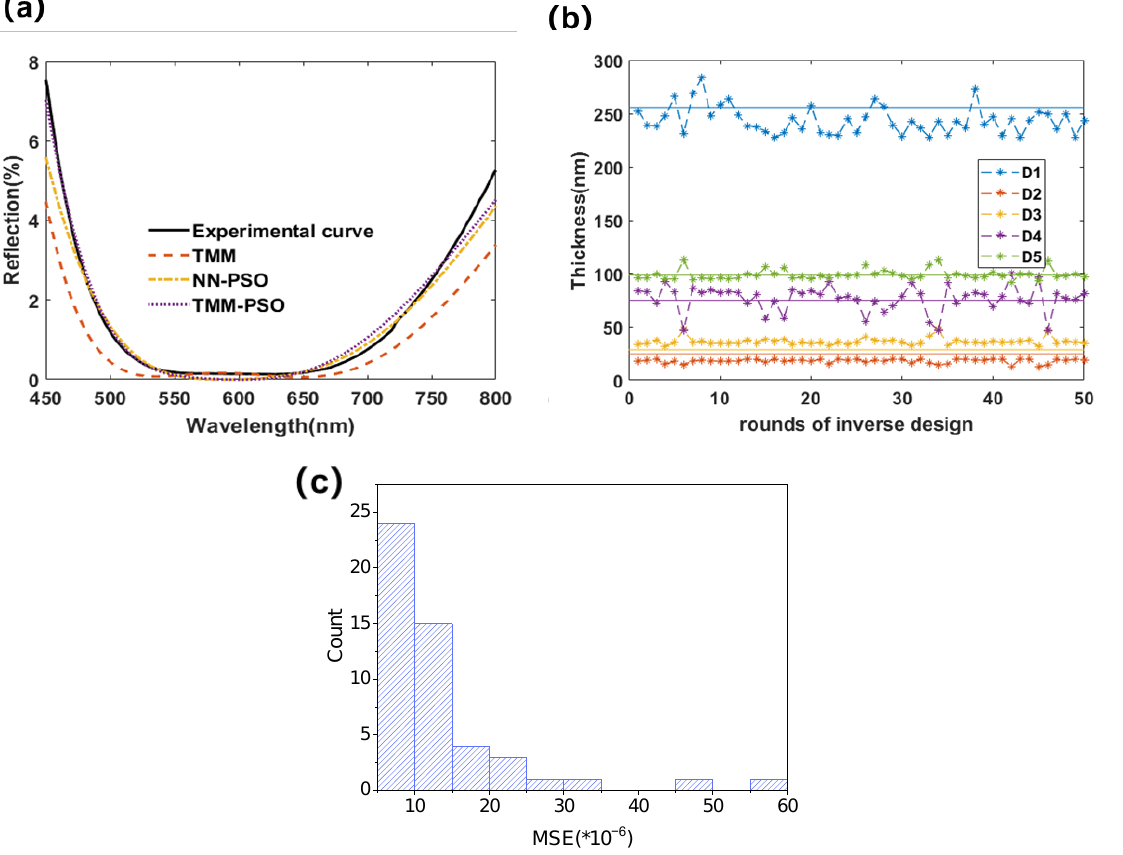
Figure 8. ( a ) The reflection curves as compared to the experiment, TMM and NN-PSO, ( b ) the distribution of the NN-PSO inversely designed layer thicknesses, and ( c ) the MSE distribution histogram of NN-PSO predicted spectra.